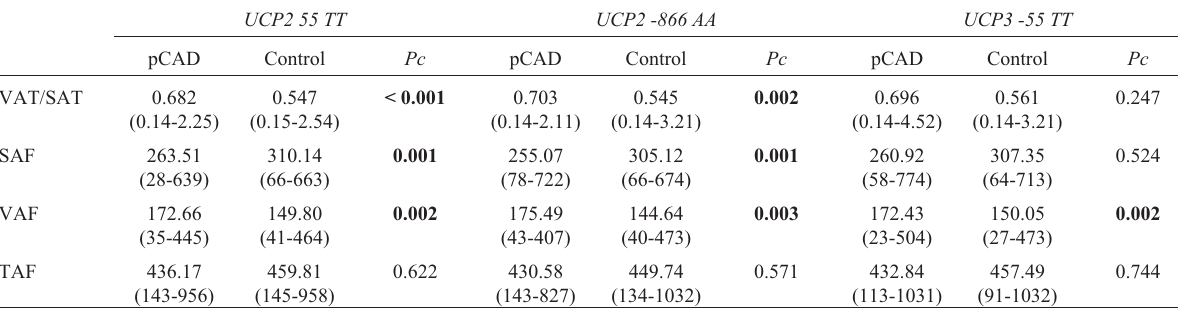
Table 4 - Association of the UCP polymorphisms with subcutaneous, visceral and total fat.